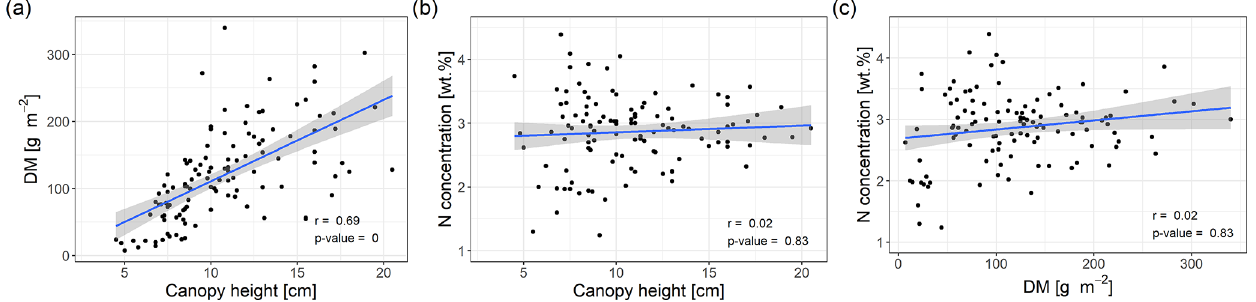
Figure 3. Scatterplots of field measurements with linear regression line. (a) Canopy height vs. DM. (b) Canopy height vs. plant N concen- tration. (c) DM vs. plant N concentration. Spearman correlation coefficients and corresponding p values are indicated in the figures. The shaded area corresponds to the standard error bounds of the fitted linear regression line.